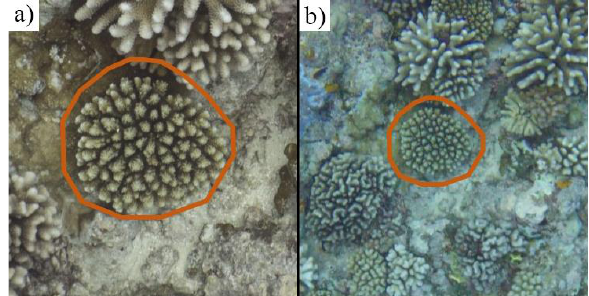
Figure 8. Selected coral used to compare the different models. a) shows a sample image from the reference camera and b) a sample image from the GoPro